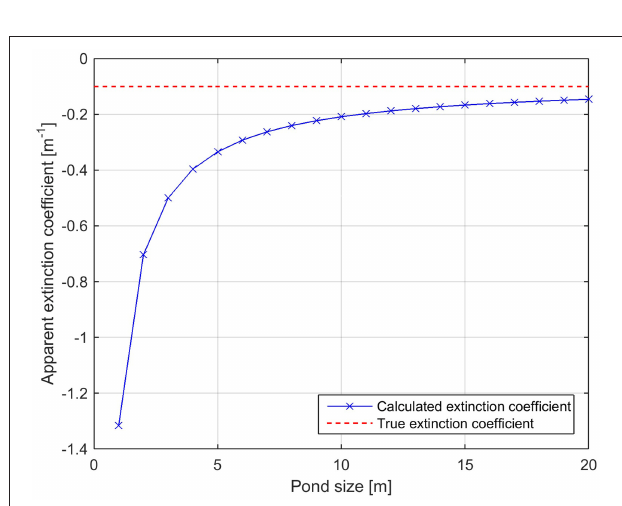
FIGURE 7 | Extinction coefficients as retrieved from vertical depth profiles under the middle of a melt-pond of varying radius.